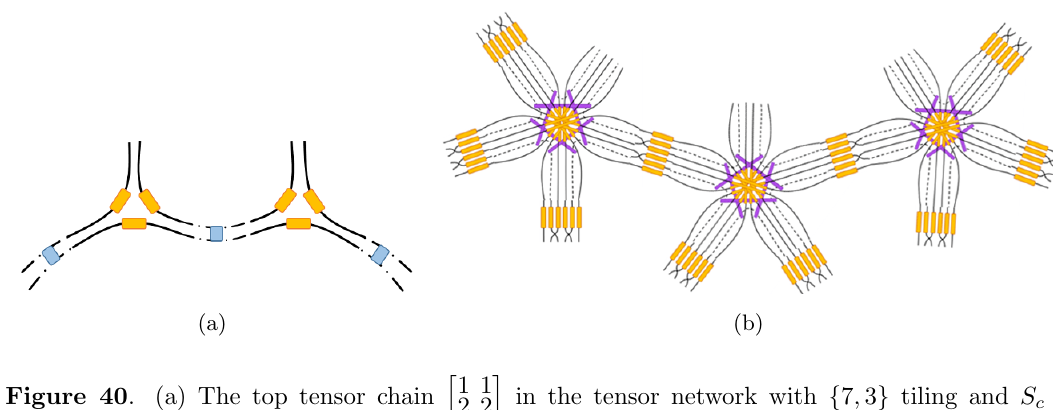
h 1 1 i in the tensor network with f 7 ; 3 g tiling and S c = 2 2 h 1 1 1 i in the tensor network with f 4 ; 5 g tiling and S c = 3 2 3